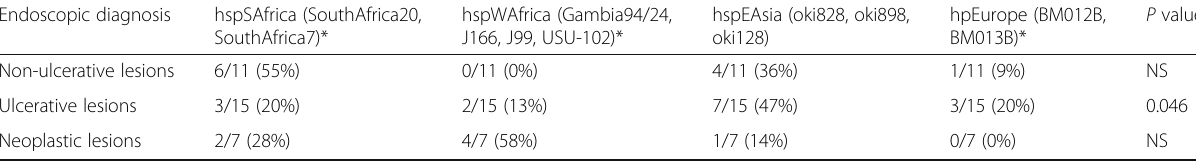
Table 3 Relation between H. pylori subpopulations and endoscopic diagnosis of the studied patients (no. 33) Endoscopic diagnosis hspSAfrica (SouthAfrica20, hspWAfrica (Gambia94/24, SouthAfrica7)* J166, J99,